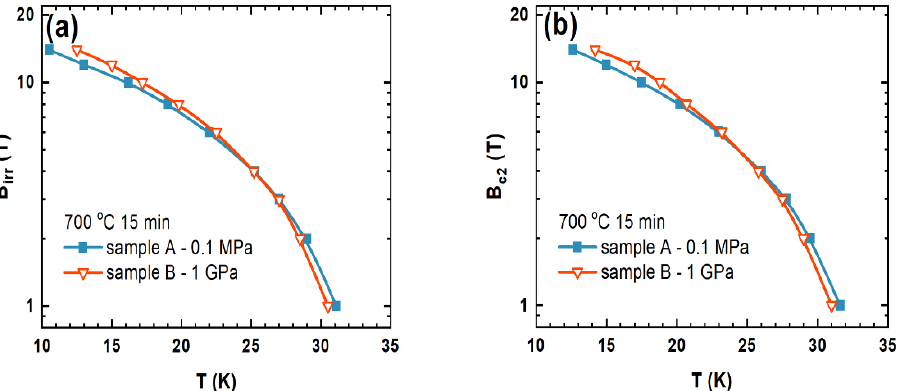
Figure 5. Transport measurements: ( a ) temperature (T ) dependence on the irreversible magnetic field ( B irr ) and ( b ) temperature ( T ) dependence on the upper critical field ( B c2 ).